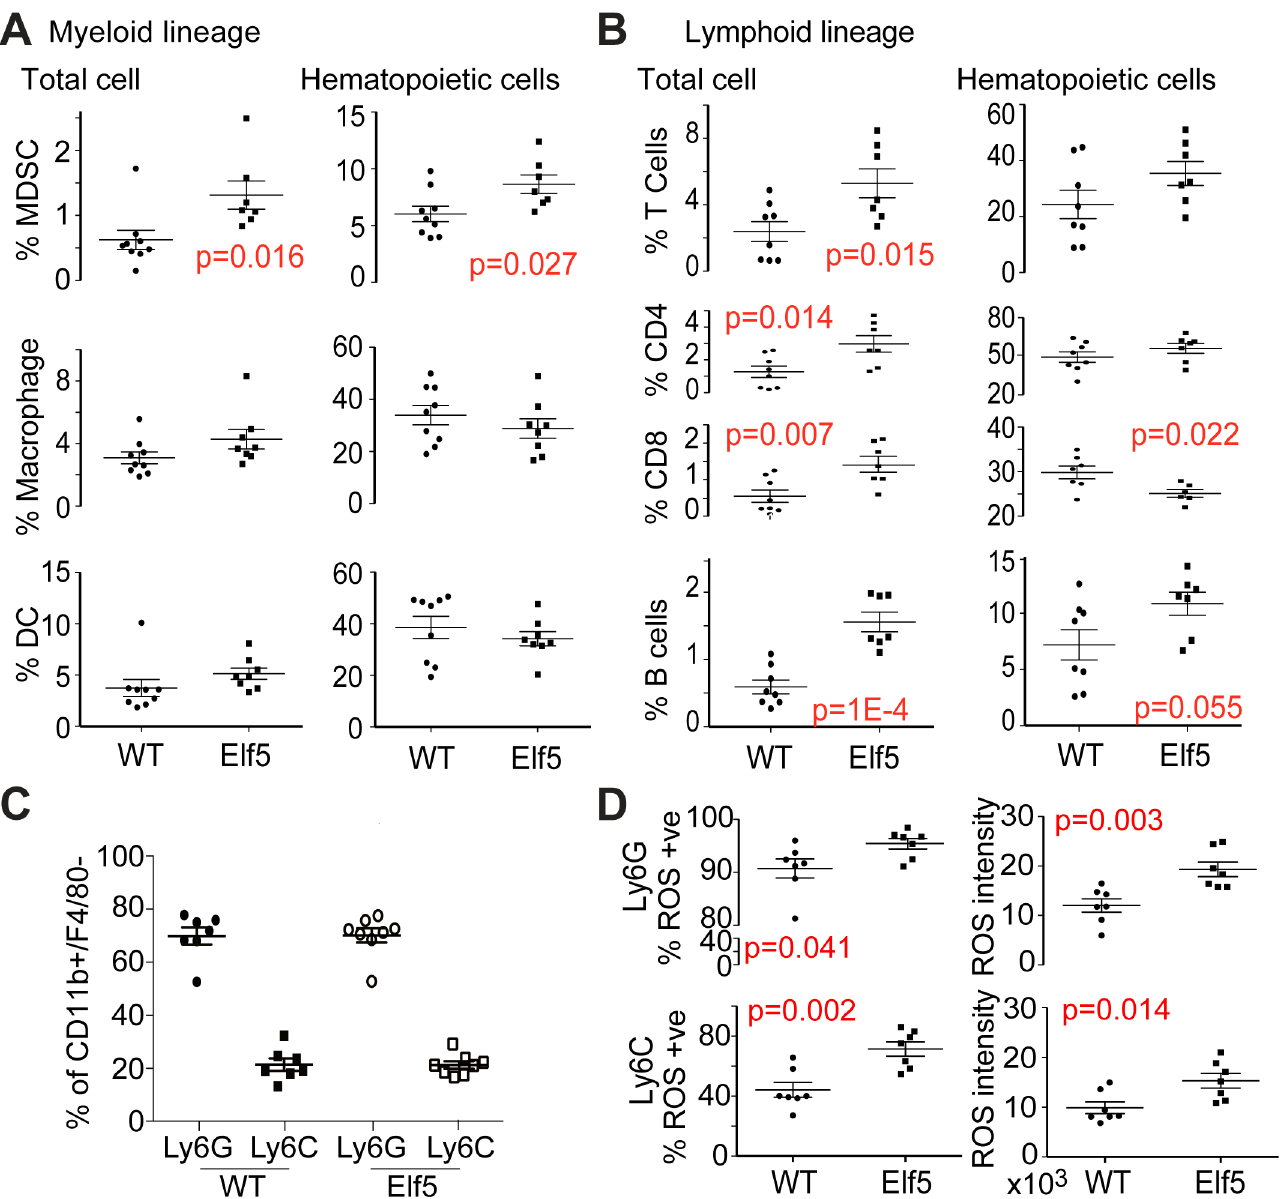
Fig 6. Immune cell subsets within tumors and the effect of depletion of MDSCs on ELF5-driven lung metastases. Panels A and B , tumor content of myeloid or lymphoid lineage immune cell subsets expressed as either a proportion of total tumor cells (after erythrocyte lysis) or as a proportion of CD45 + hematopoietic cells. S5 Fig shows the gating strategy. Panel C , relative proportions of Ly6G and Ly6C MDSC in mice of the indicated genotypes (Ly6G/ Ly6C ratio between genotypes are nonsignificant Student ’ s t test p = 0,886). Panel D , the effect of ELF5 on the proportion of reactive oxygen species (ROS) positive Ly6C or Ly6G cells (LHS panels) or on ROS cellular intensity measured as geometric mean (RHS panels). Nonsignificant p -values are not